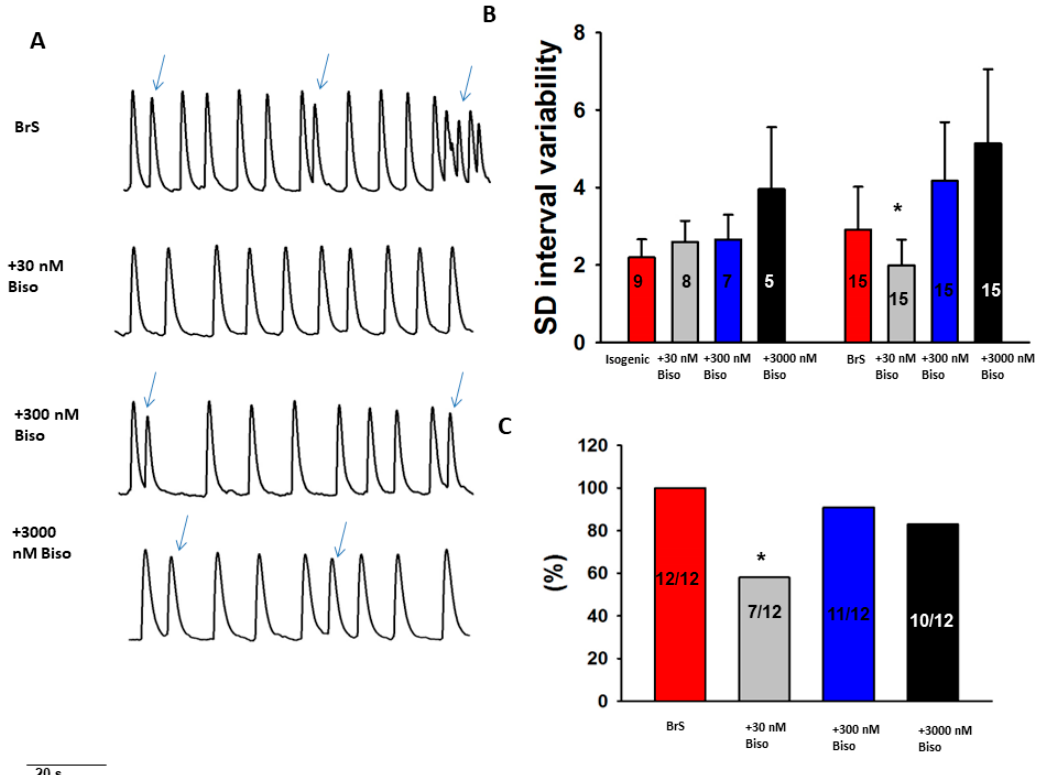
Figure 6. Effects of beta-blocker on the beating variability and arrhythmic events in BrS-hiPSC-CMs. Spontaneous calcium transients were recorded in regularly beating hiPSC-CMs from the BrS patient and the isogenic control(isogenic) in the absence (baseline) and presence of 30 nM, 300 nM and 3000 nM bisoprolol (Biso). The beating variability (standard deviation (SD) of cell beating intervals) and the occurrence of arrhythmic events (irregular or triggered beats or EAD-like events) were compared between with and without drug application. ( A ) Representative trace of BrS (at baseline) and after the administration of different concentrations of bisoprolol. ( B ) Mean values of standard deviation (SD) of cell beating intervals. ( C ) Percentage of cells showing arrhythmic events. * p < 0.05 versus isogenic according to Fisher’s exact test ( C ) or versus baseline according to t -test ( B ).